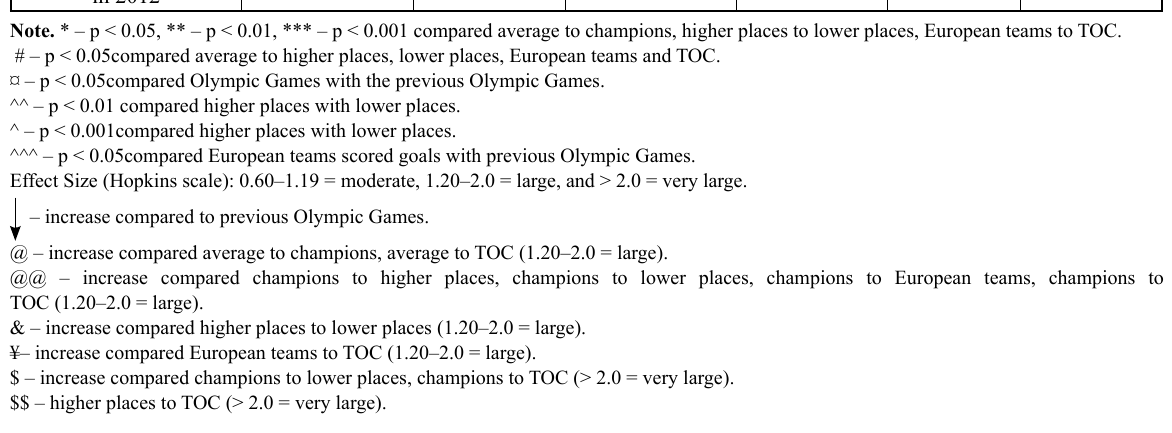
Discriminant analysis between ranking teams champions. A team which became champions in all Olympics scored more goals than other teams on average, except for the London Olympics (Table 2). The greatest values of goals were made by Danish national team (32.8 ± 4.2) in the Sydney OG, and the lowest goals were scored by USSR team in the Montreal Olympics (19 ± 8.2) (but the match lasted 50 minutes). Difference between teams 1–4 and 5–12. Teams took higher places (Table 2) and scored